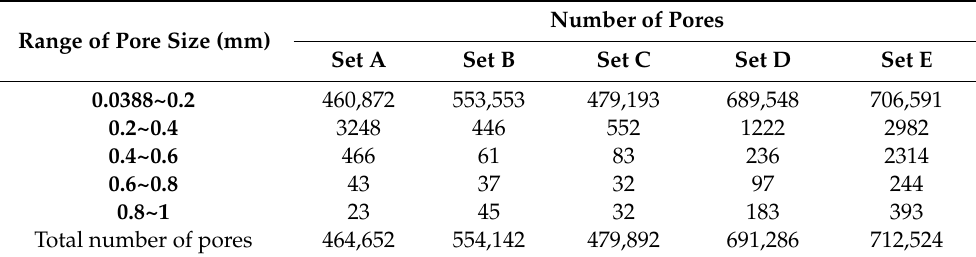
Table 6. Pore size distribution for the representative specimen in each set of process parameters.